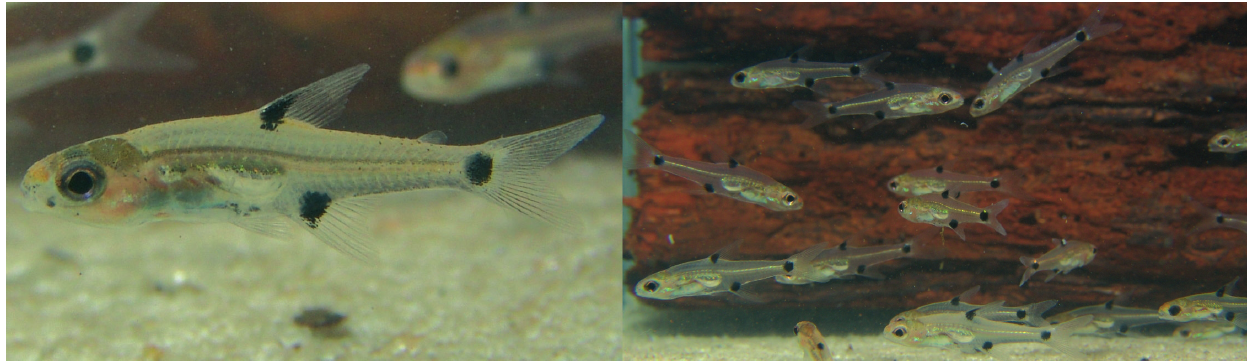
Fig. 7. Live specimens of Amazonspinther dalmata . In detail a specimen on the left and a school of specimens as observed in the field on the right (photos by Fernando Mendonça).